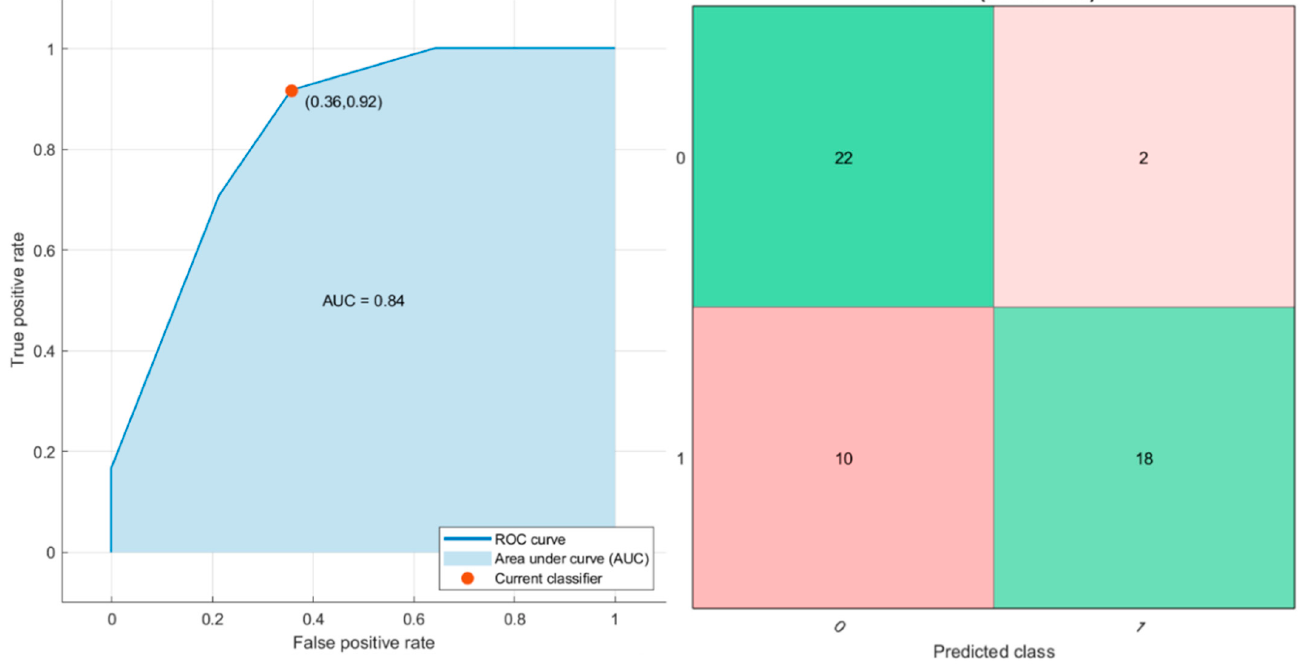
Figure 4. ROC curve, confusion matrix and graphical view of the decision tree considering the robust features by LASSO method to use as predictors.